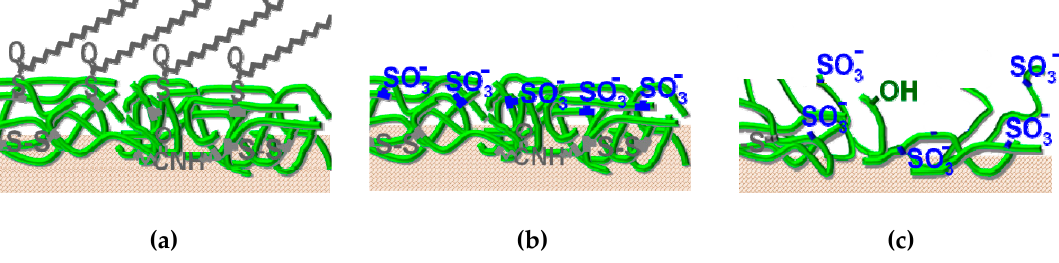
Figure 14. Schematic illustration of epicuticle’s degradation process. ( a ) Untreated Hair (Root part). ( b ) B4 hair which represents chemically damaged hair. ( c ) B4W hair which represents chemically damaged and weathered hair.